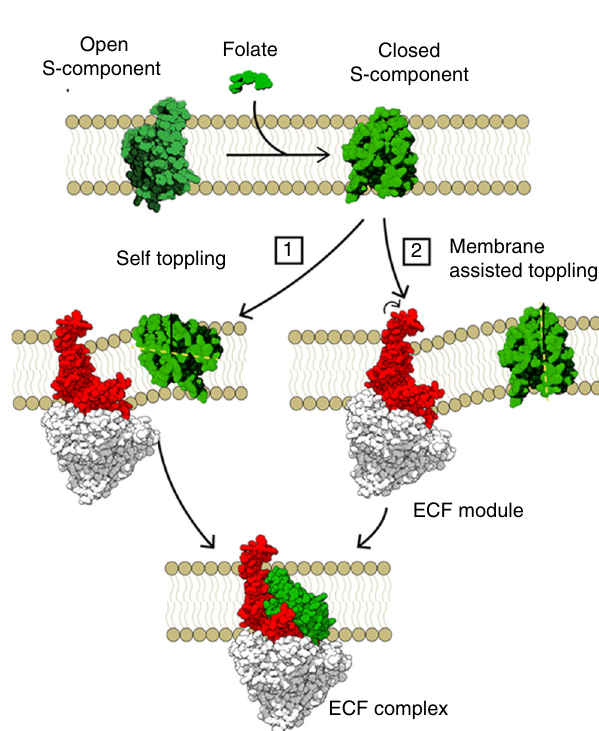
Fig. 6 Mechanism proposed for the transport of folate by the group II ECF transporter ECF-FolT2. Once the open (canonical) S-component binds folate there are two pathways that the substrate-bound S-component can follow to bind the hydrophobic surface of the ECF module. In the fi rst, the S-component can topple over inside the membrane possibly due to local fl uctuations of the membrane and bind the ECF module in the orientation observed in crystallographic structures of ECF complexes. As a second pathway, the S-component can slide towards the ECF module thanks to the negative bending around the ECF module.